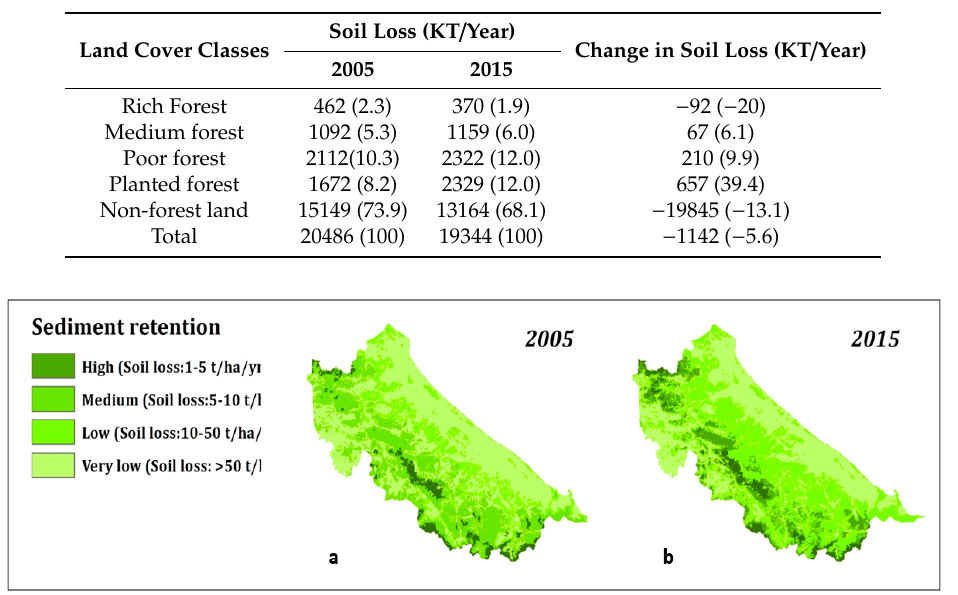
Table 7. Estimate change in soil loss in Qu ả ng Tr ị and Th ừ a Thiên-Hu ế Provinces from 2005 to 2015 (t / year) and the percentage is indicated in the parenthesis.